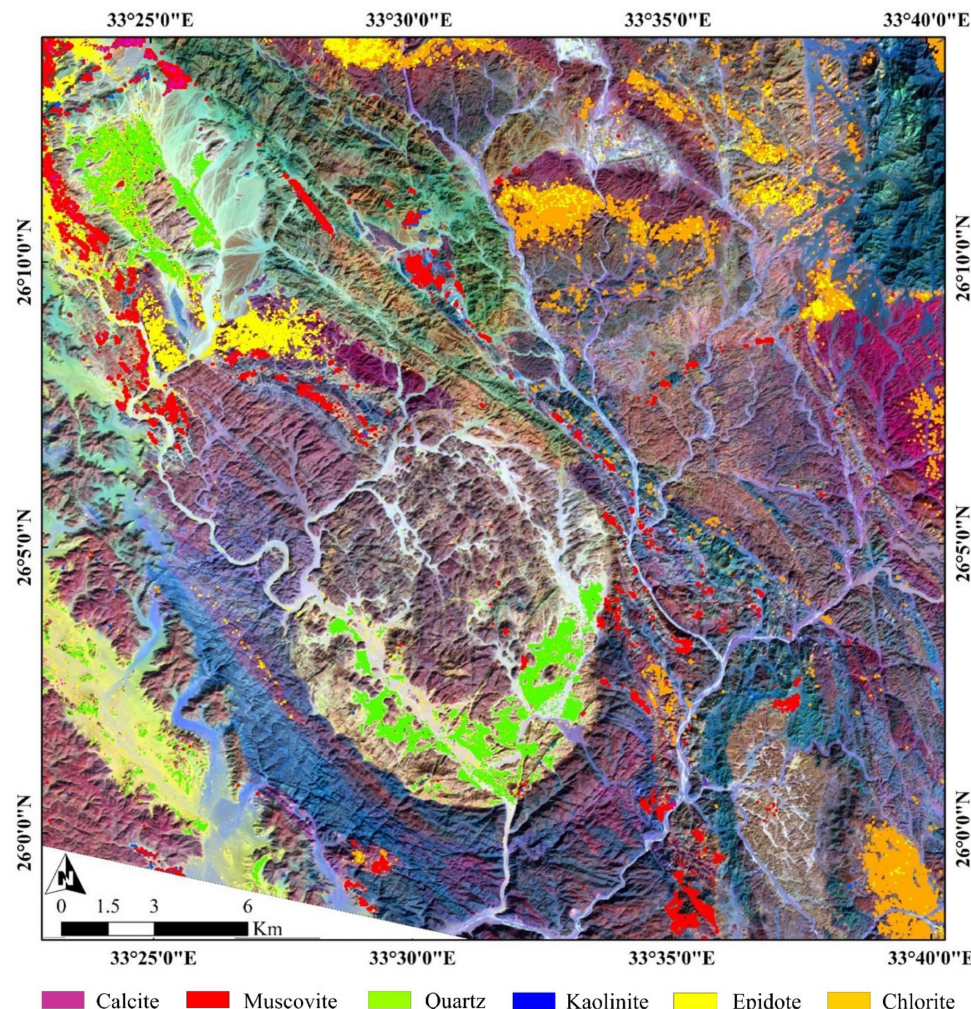
Figure 9. CEM results (distribution of six minerals commonly associated with different types of alteration) over 2.5 m pan-sharpened Sentinel 2 FCC (RGB b11, b8,